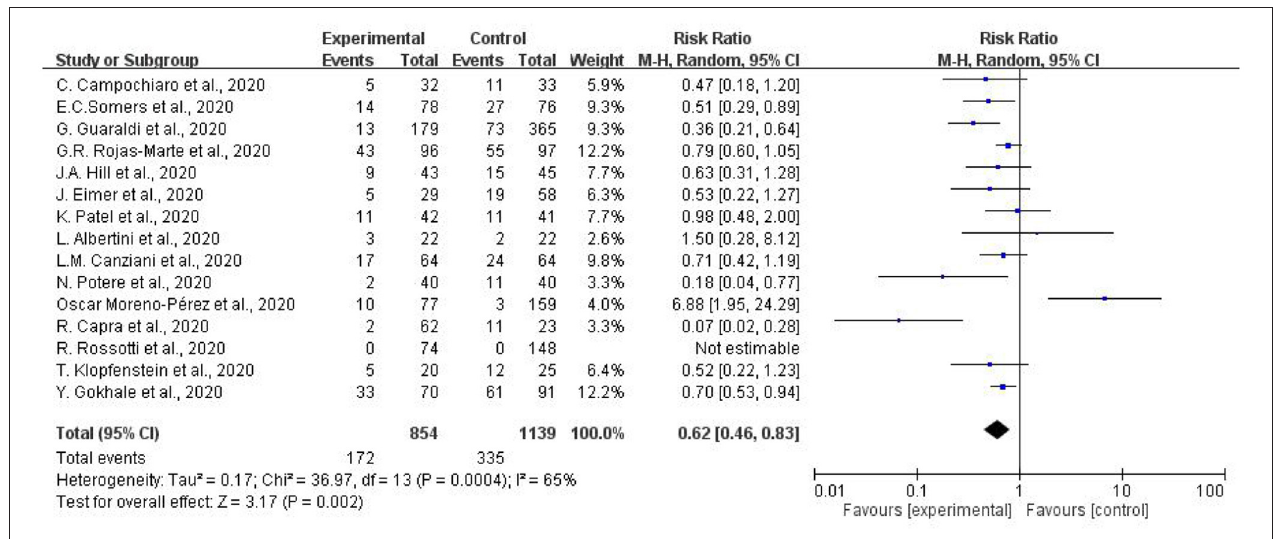
FIGURE 2 | Meta-analysis of effects of tocilizumab on coronavirus disease-2019 (COVID-19) (risk ratio).